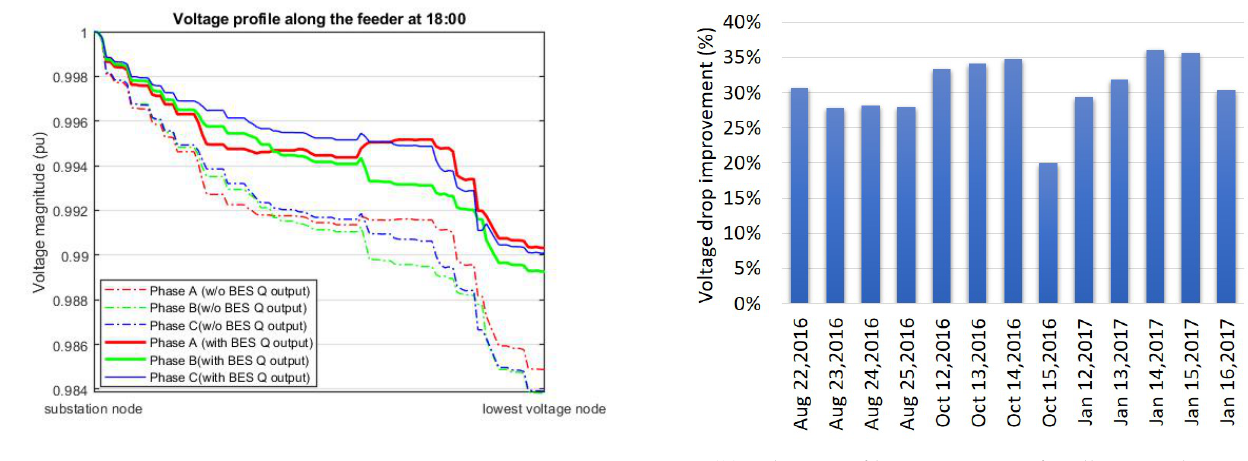
Figure 7. Voltage profile improvement results.